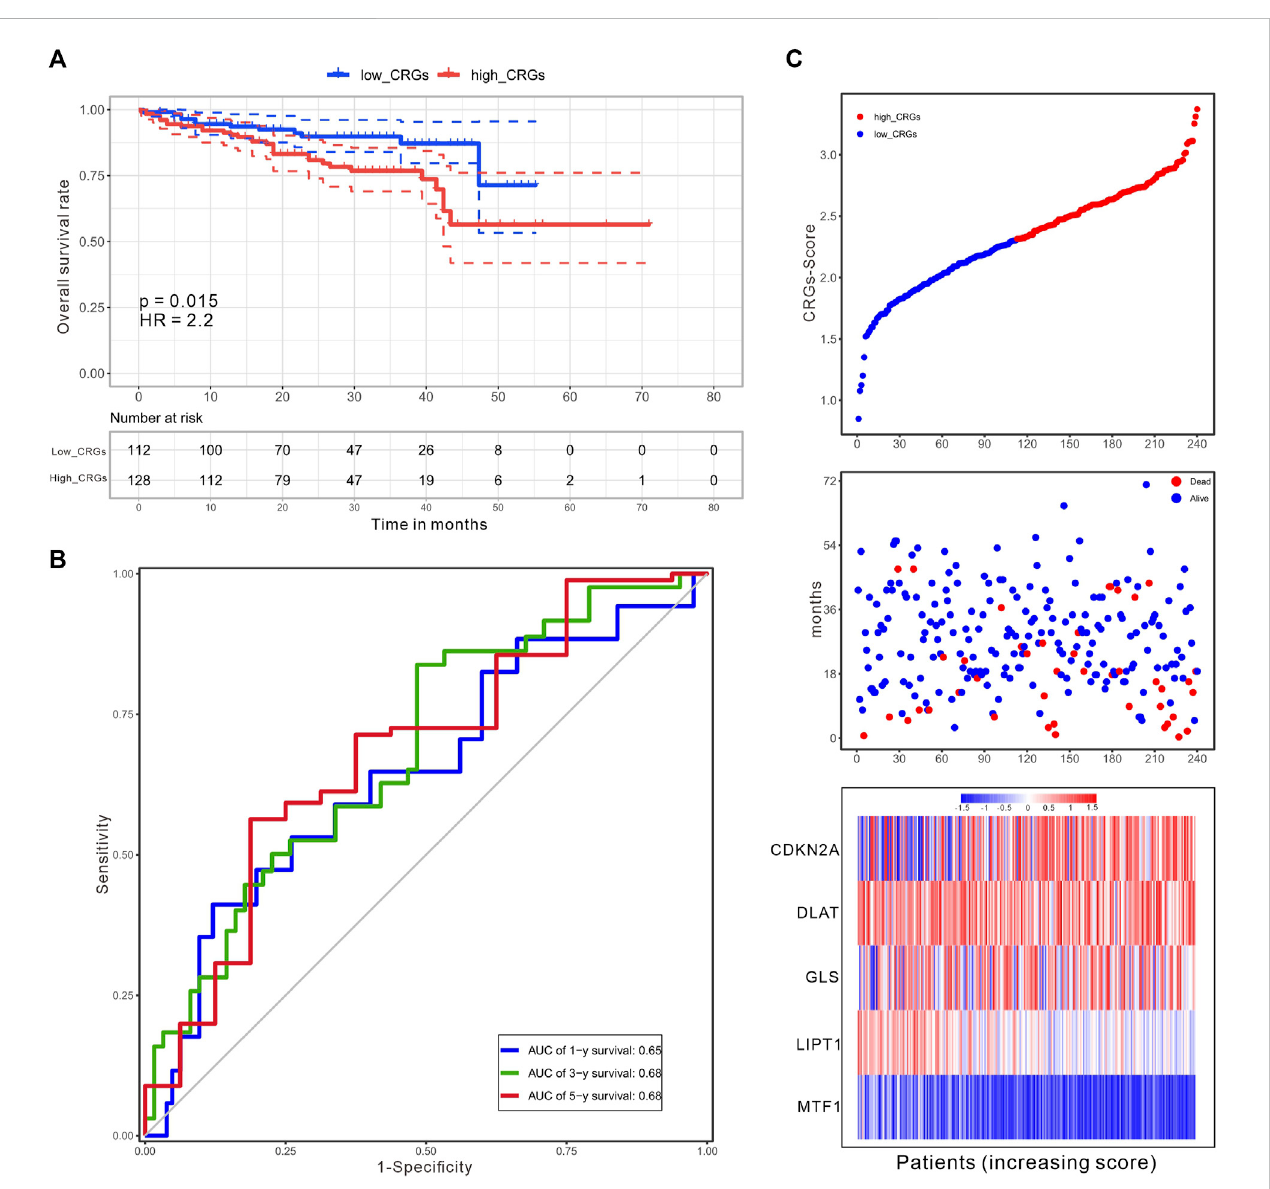
FIGURE 9 An independent validation of the CRGs-score with the ICGC cohort. (A) The KM curves for overall survival of 240 HCC patients between low and high CRGs-score subgroups (Log-rank test, p = .015, HR = 2.2). (B) The time-dependent ROC analysis of CRGs-score. The AUC values were .65, .68, .68 at 1 year, 3 years, and 5 years, respectively. (C) The increasing of CRGs-score, survival status, and heatmap of fi ve prognostic CRGs in the ICGC